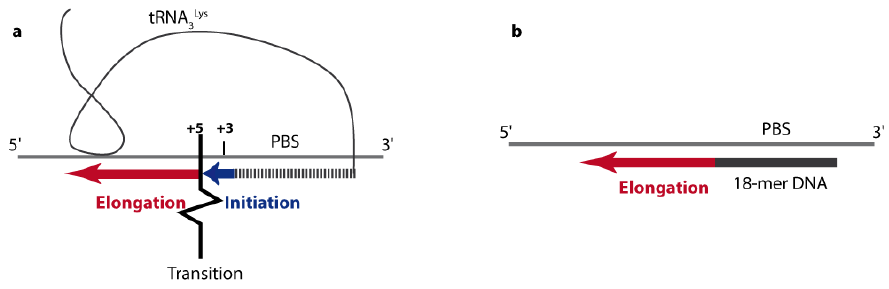
Figure 3. Schematic representation of HIV-1 specific initiation (a) versus unspecific elongation (b) of reverse transcription. The vRNA template is represented by a thin grey line. The natural tRNA 3Lys primer or an 18 mer DNA primer are in black and the newly synthesized DNA is represented by thick blue and red lines representative of the initiation and elongation steps of reverse transcription, respectively. In the presence of the natural tRNA primer, transition between initiation and elongation occurs after the addition of the first 6 nucleotides to the 3’ end of the primer. In the case of the HIV-1 MAL isolate, transition is facilitated by the anticodon/A-rich loop interaction upstream of the PBS, represented by the close contact between tRNA 3Lys and the